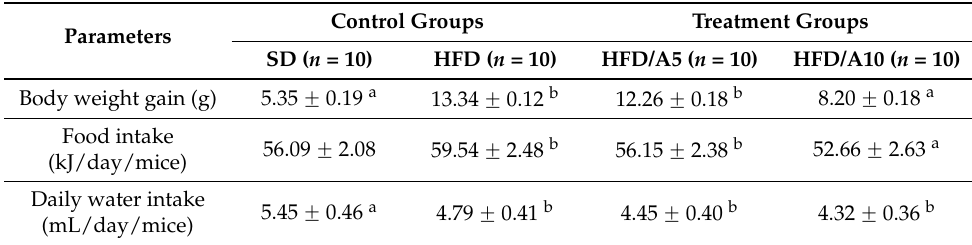
Table 1. Body weight gain, intake food and water in all groups of mice. Control Groups Treatment Groups Parameters